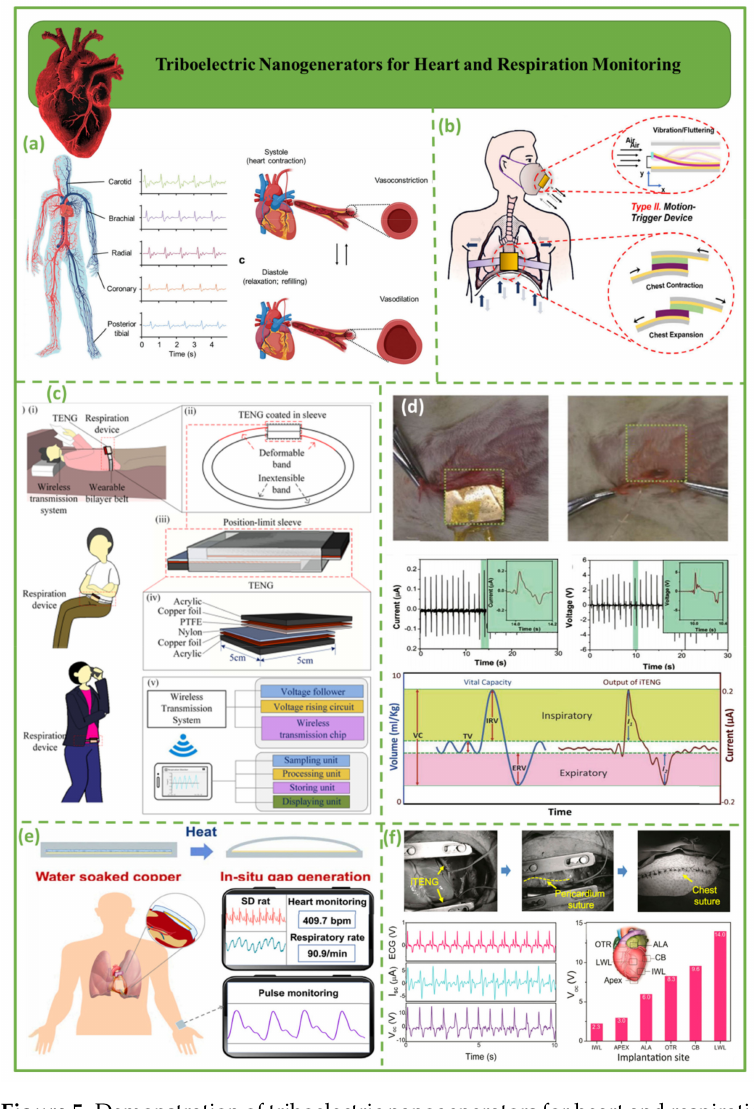
Figure 5. Demonstration of triboelectric nanogenerators for heart and respiration monitoring. ( a ) Wear- able triboelectric nanogenerators for heart rate monitoring [81]. ( b ) Respiration-driven triboelectric nanogenerators for biomedical purposes [82]. ( c ) A portable triboelectric nanogenerator to measure respiration in real time [83]. ( d ) An in vivo pacemaker running on an implanted triboelectric nanogen- erator powered by the patient’s breathing [87]. ( e ) Eco-friendly in situ gap generation of a no − spacer triboelectric nanogenerator to monitor cardiovascular activities [88]. ( f ) Self − powered wireless cardiac monitoring is provided by the implanted triboelectric nanogenerator in the in vivo system